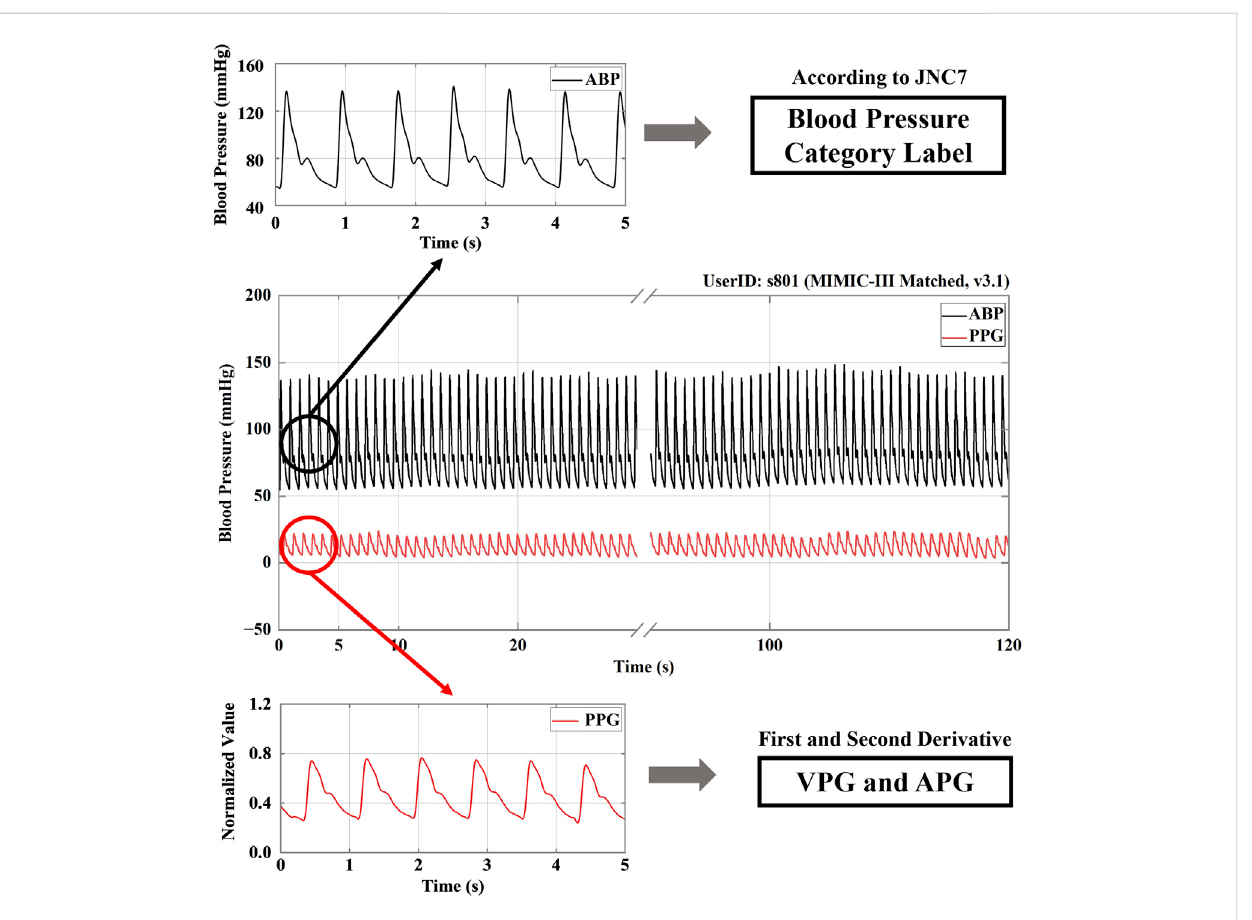
FIGURE 1 A signal processing structure. Note: ABP stands for arterial blood pressure; PPG, VPG, and APG refer to photoplethysmography, velocity plethysmography,andaccelerationplethysmography,respectively.JNC7 standsfortheseventhreportoftheUnitedStatesJointNationalCommitteeon Prevention, Detection, Evaluation and Treatment of High Blood